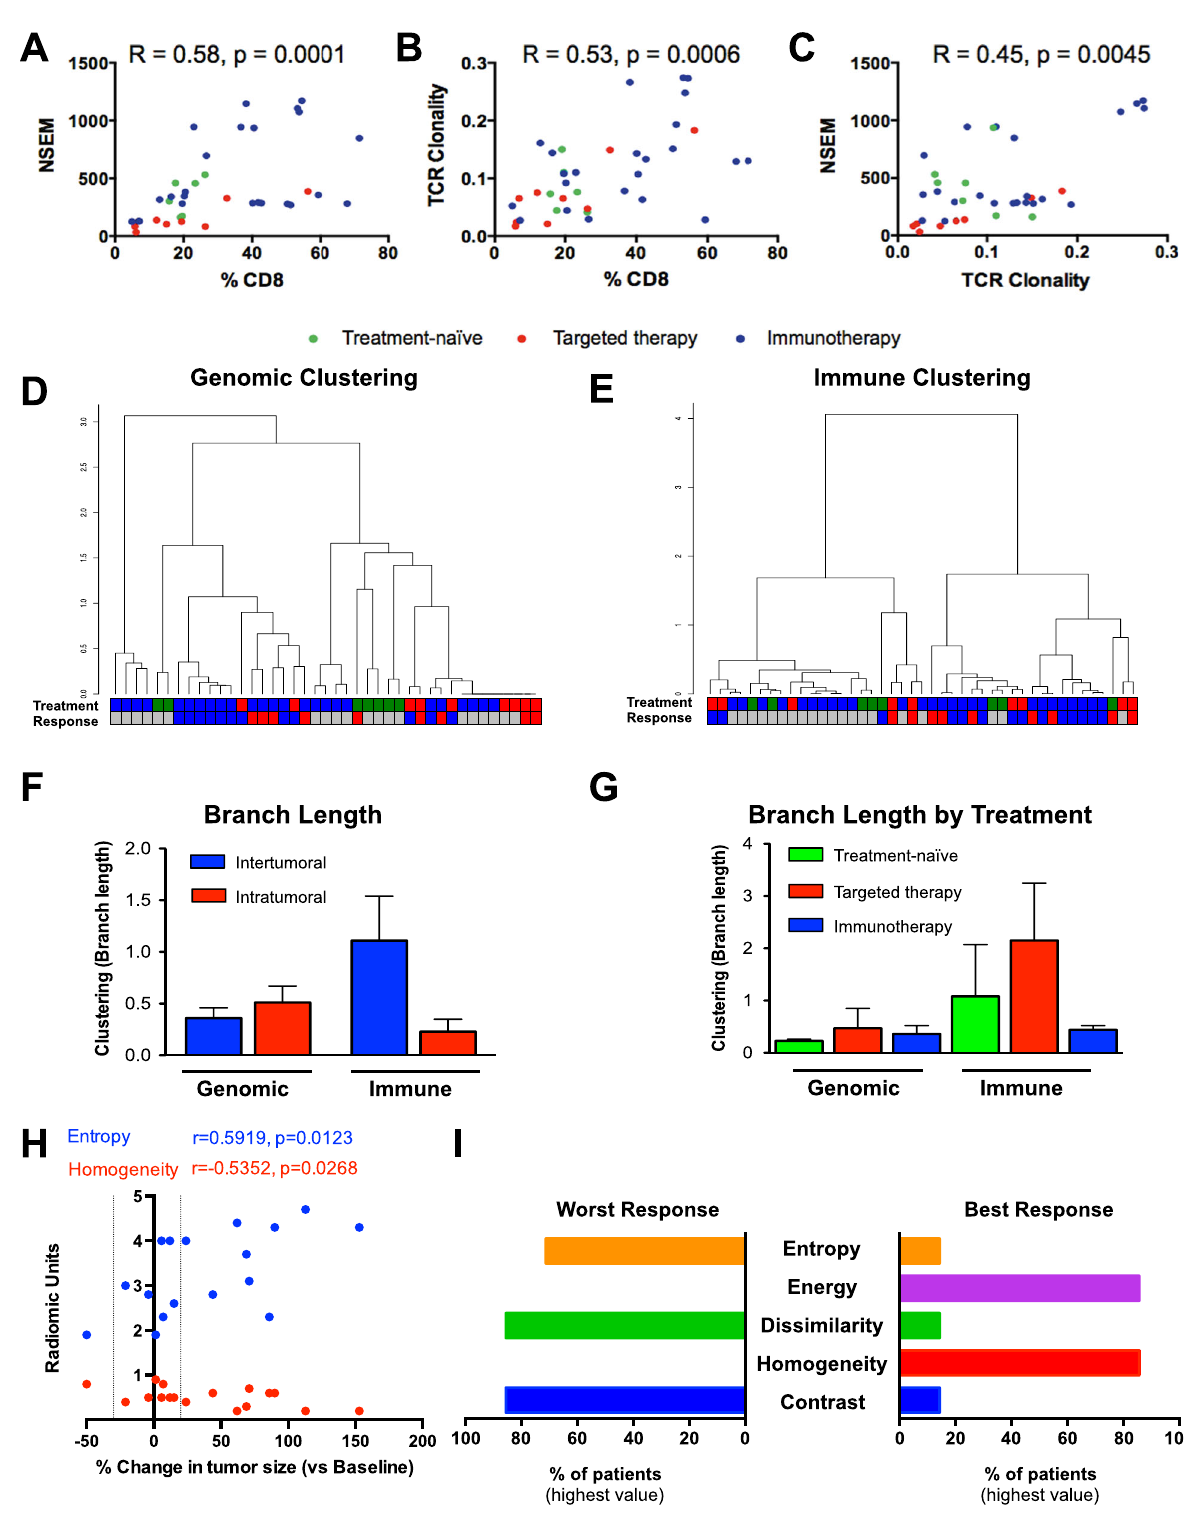
Fig. 4 Genomic and immune heterogeneity are associated with differential tumor growth, and response to targeted therapy and immune checkpoint blockade. Genomic and immune data were studied, and a somatic NSEM and CD8%, b CD8% and TCR clonality and c somatic NSEM and TCR clonality were plotted to show correlation. Agglomerative Ward ’ s hierarchical clustering of individual samples based on genomic ( d ) and immune ( e ) parameters. f Average clustering branch length of genomic and immune parameters of different regions of the same metastasis ( red ) and different metastases in the same patient ( blue ). g Average clustering branch length of genomic and immune parameters based on treatment background. h Correlation between radiographic change in tumor size from baseline and radiomic texture analysis features such as entropy ( blue ) and homogeneity ( red ). i Percentage of patients in whom the best and worst responding synchronous lesions within each patient show the highest entropy, energy, dissimilarity, homogeneity, and contrast by texture